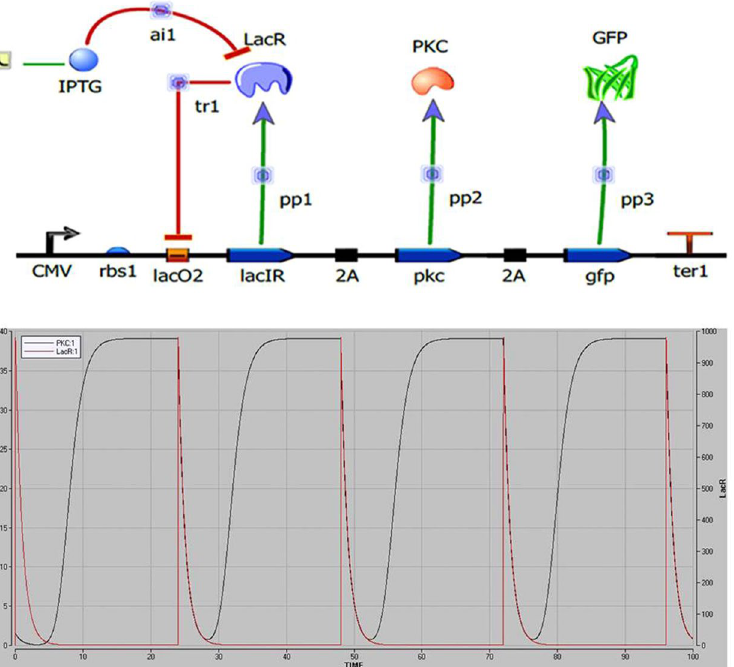
Figure 3. ( a ) Circuit Design; and ( b ) simulation results showing oscillations between the LacR and PKC due to the intermittent pulse of IPTG of 1